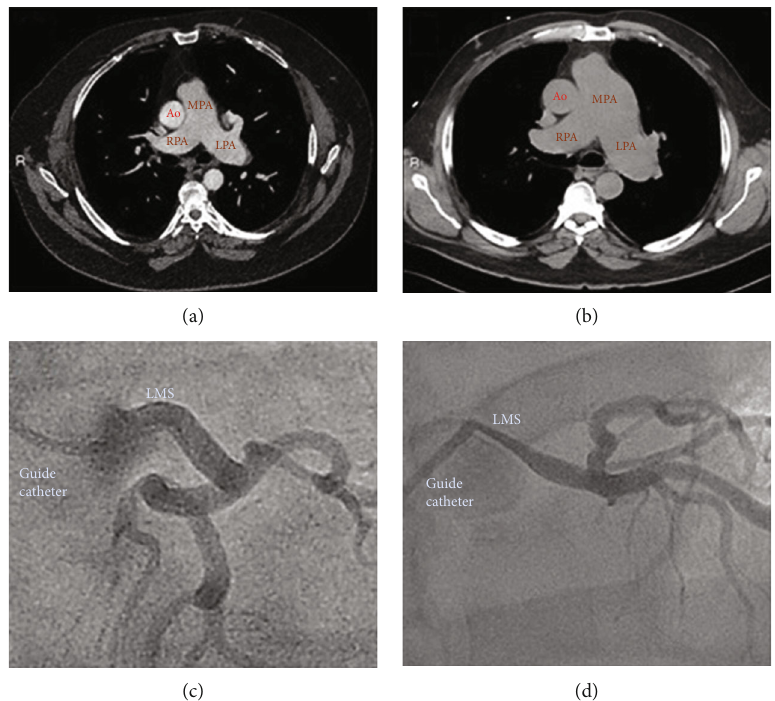
Figure 3: (a) CT scan showing main pulmonary artery with a diameter of 33mm in 2013; (b) CT scan showing main pulmonary artery with a diameter of 58mm in 2020; (c) normal appearance of LMCA in 2013; (d) severe tapering stenosis of LMCA in 2020. MPA=main pulmonary artery; RPA=right pulmonary artery; LPA=left pulmonary artery; Ao =ascending aorta; LMS=left main stem.